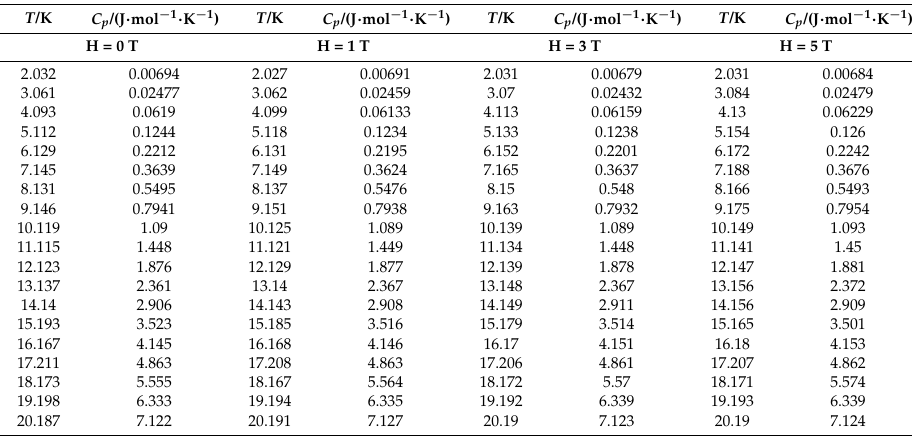
Table 2. Magnetic-field dependence of heat capacity of L -valine (11.33 mg) at 2–20 K. T